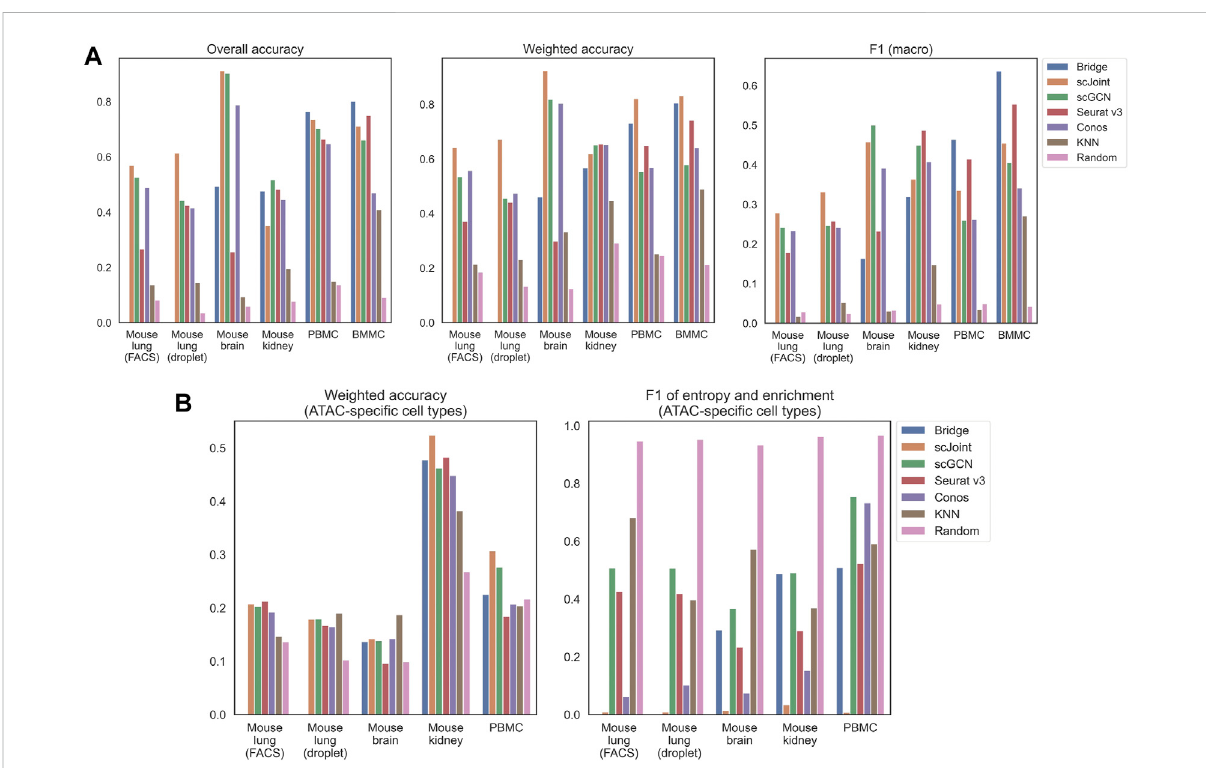
FIGURE 1 Performance of label transfer methods on single-cell data from selected mouse and human tissues. (A) Overall metrics considering performance on all scATAC-seq cells. (B) Metrics calculated on scATAC-seq cells labeled with ATAC-speci fi c cell types. The Bridge results shown here for the mouse brain used SNARE-seq as the multimodal “ bridge ” . Comparison of results using SNARE-seq and SHARE-seq can be found in Supplementary Figure S1. For mouse lung (both FACS and droplet), Bridge integration was not considered because of no available multimodal